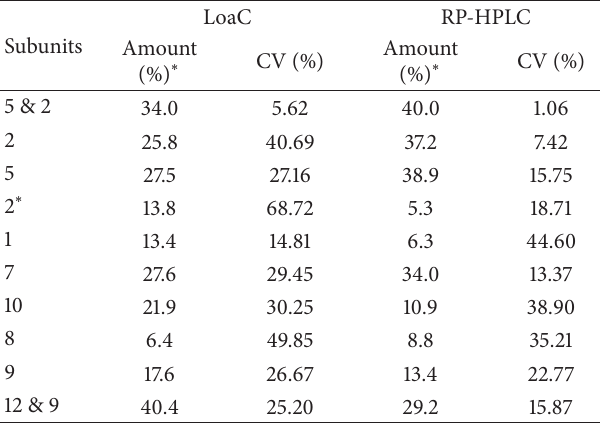
∗ Expressed as relative amount: percentage of individual HMW area to total HMW